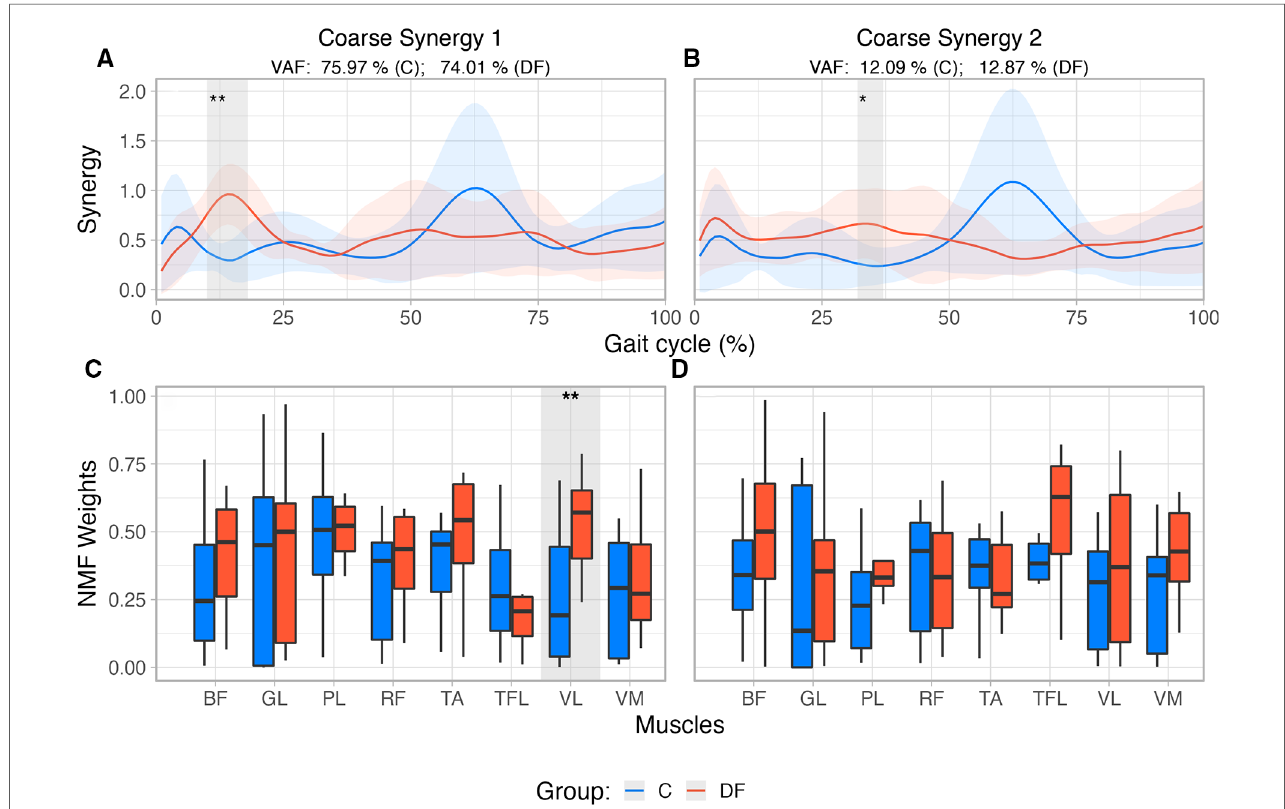
FIGURE 2 ( A , B ) Reconstructed muscle activity pro fi les based on weights extracted from fi rst two coarse synergies for each group, accounting for >86% of variance in each group. Shaded areas identify differences between groups based on SPM{t} results and their corresponding levels of signi fi cance. ( C , D ) Coarse synergies muscle weights extracted from NMF for unimpaired control participants (C) and persons with drop foot (DF). (cid:4) Signi fi cant at 5%; (cid:4)(cid:4) Signi fi cant at